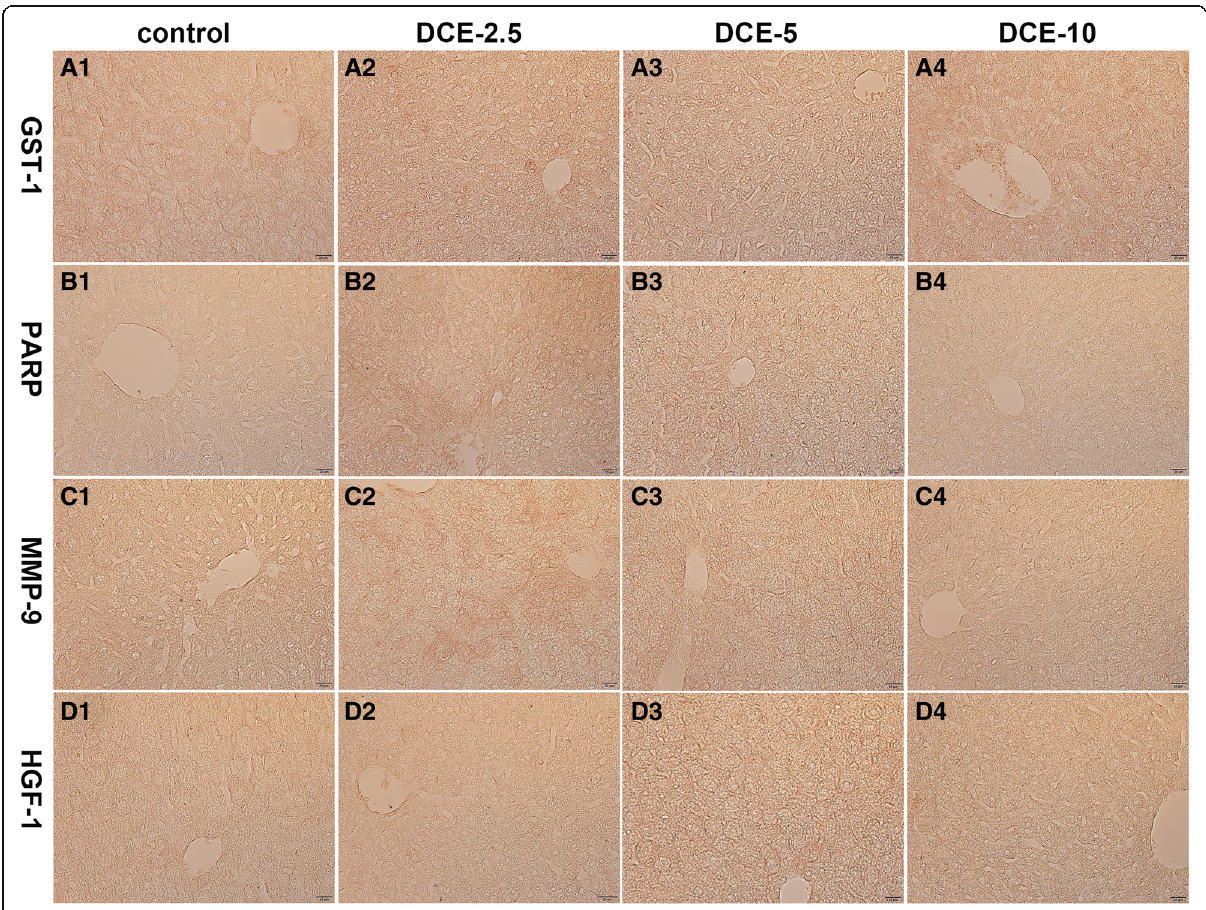
Fig. 2 Photomicrographs of mouse liver, immunohistochemical staining for GST-1, PARP, MMP-9, and HGF-1. a GST-1 expression was increased dose-dependently by DCE-2.5 to DCE-10. b PARP was markedly positive in the DCE-2.5 group. c MMP-9 was strongly positive in the DCE-2.5 group. d HGF-1 was gradually and dose-dependently increased by